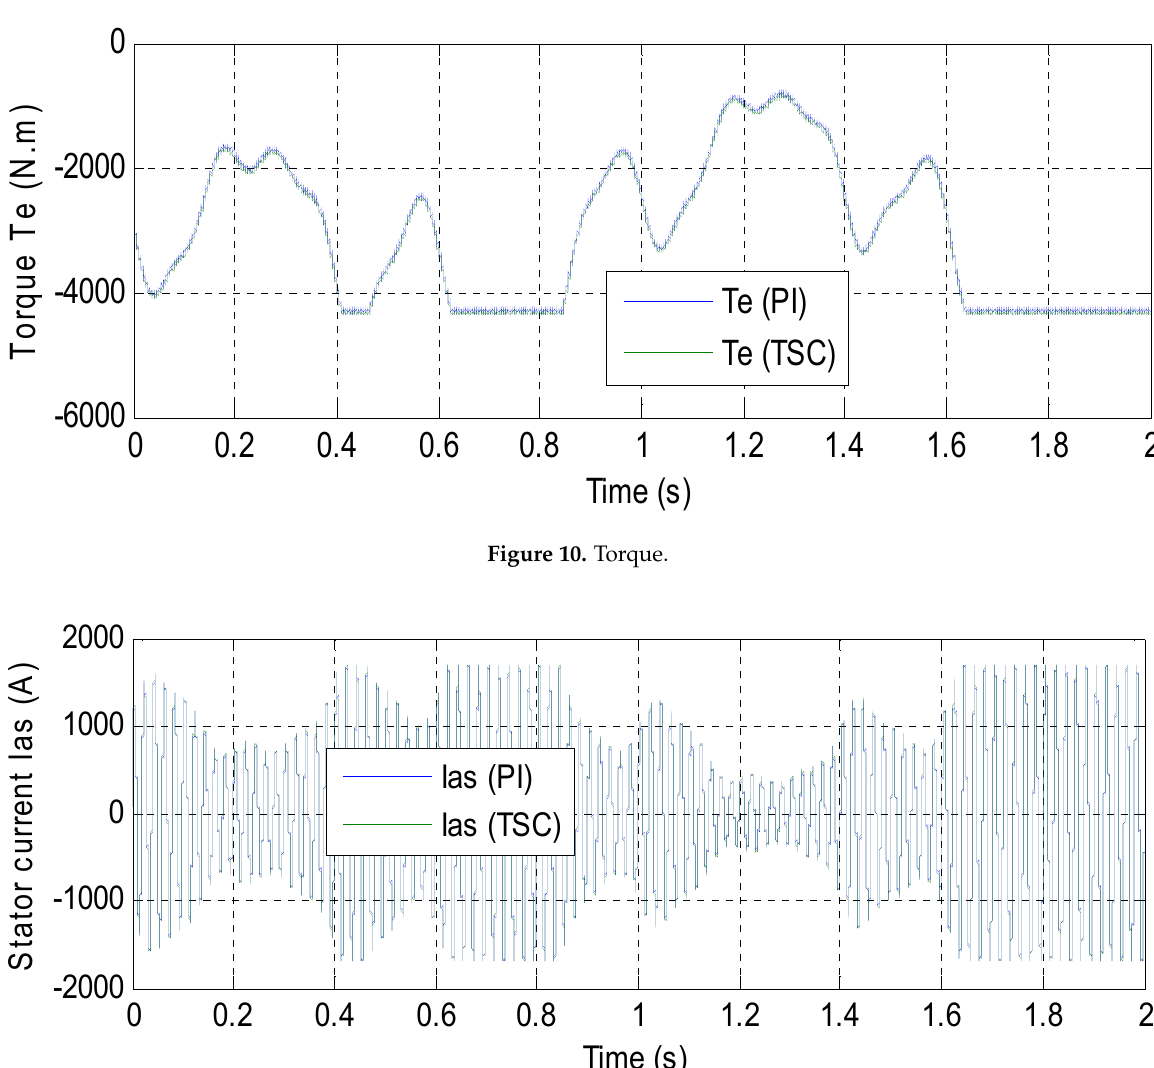
Figure 11. Current. Figure 11.